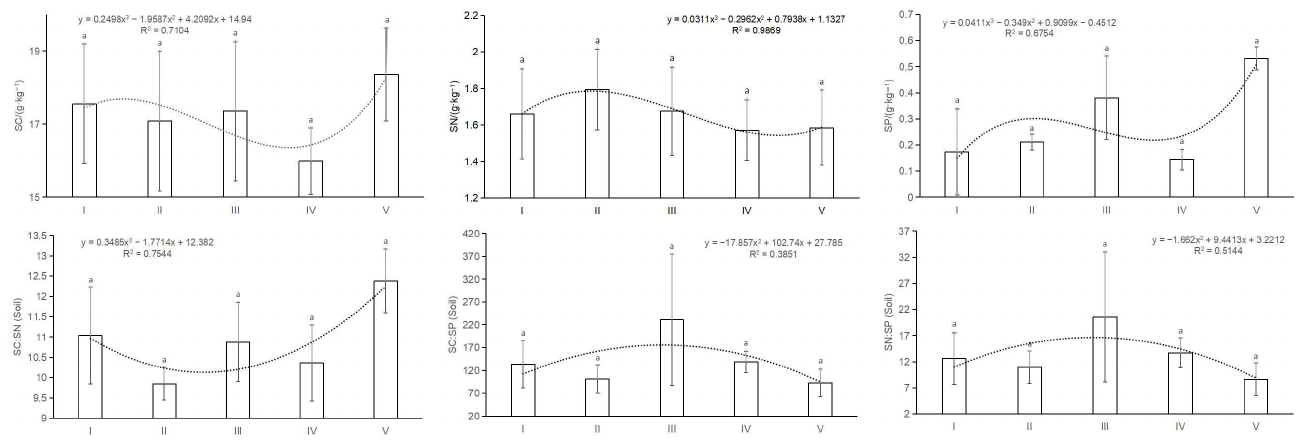
Figure 4. Effects of SC, SN, and SP contents and stoichiometric characteristics caused by Moso bamboo expansion into Chinese fir forests (SC: soil carbon; SN: soil nitrogen; SP: soil phosphorus, the same as follows).